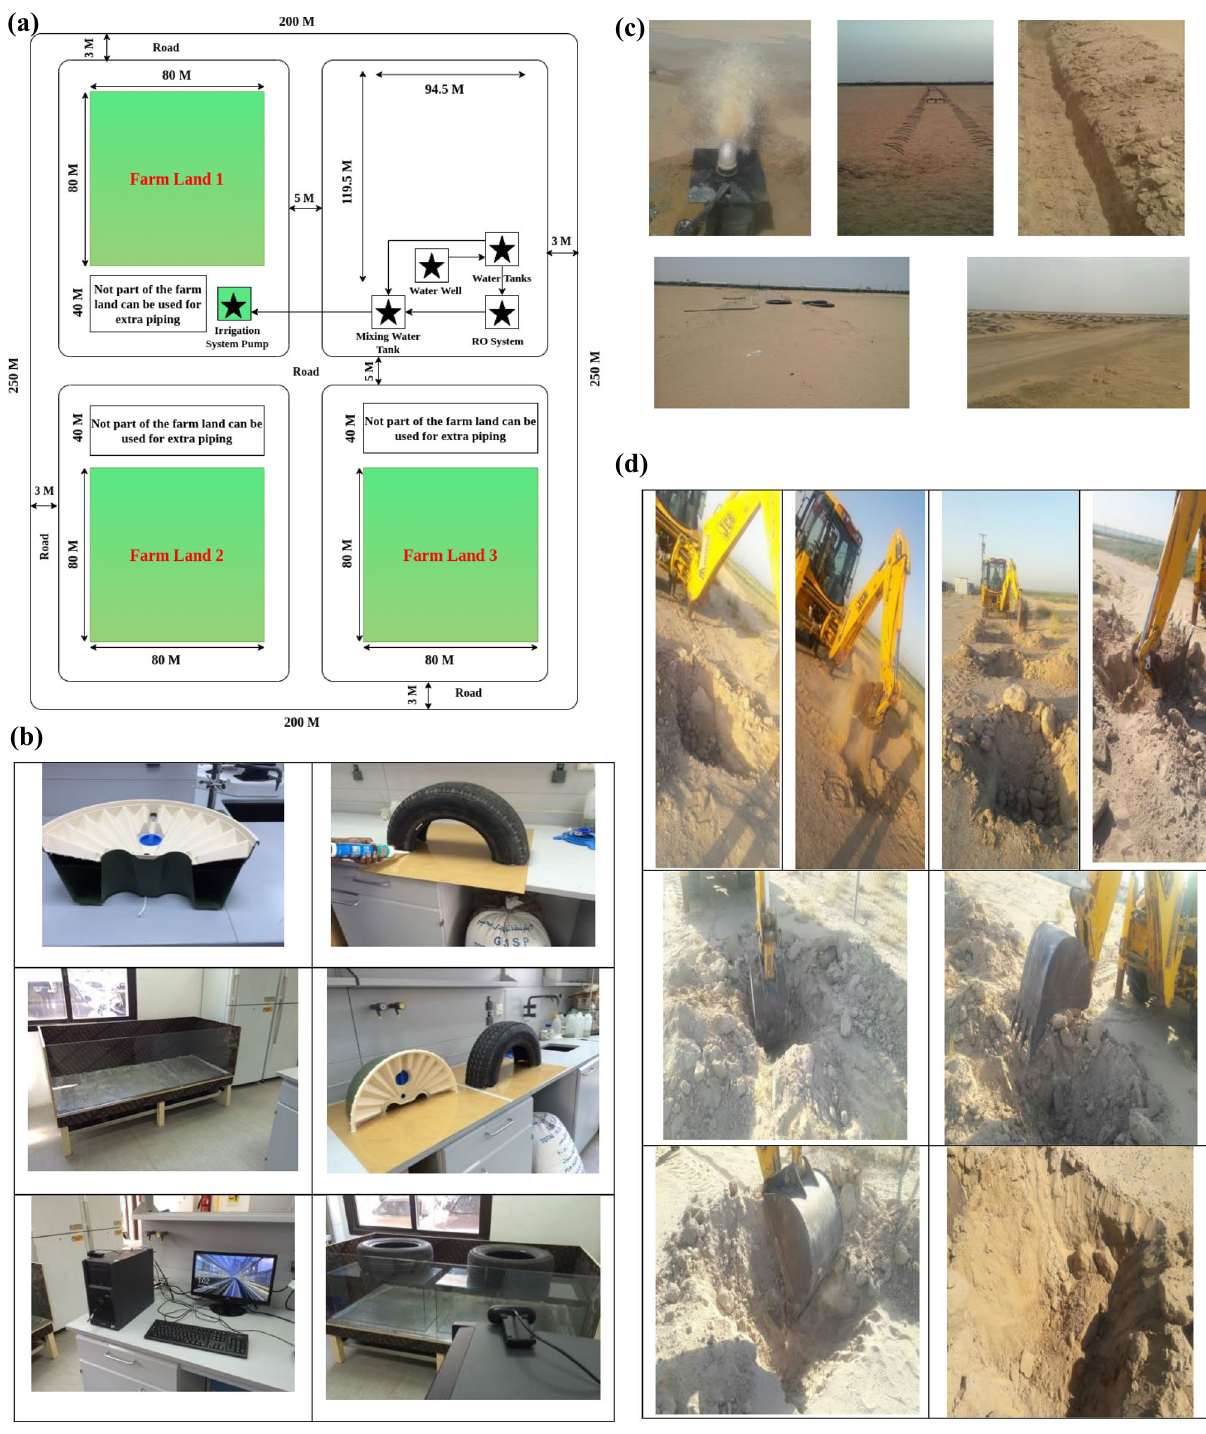
Figure 10. ( a ) A proposed structure of a test site. ( b ) Various pictures of the box are manufactured and designed for a controlled test environment. ( c ) Various pictures of the land being prepared and ready for use as a field test environment. ( d ) Various pictures of the test site preparation land used as a field test